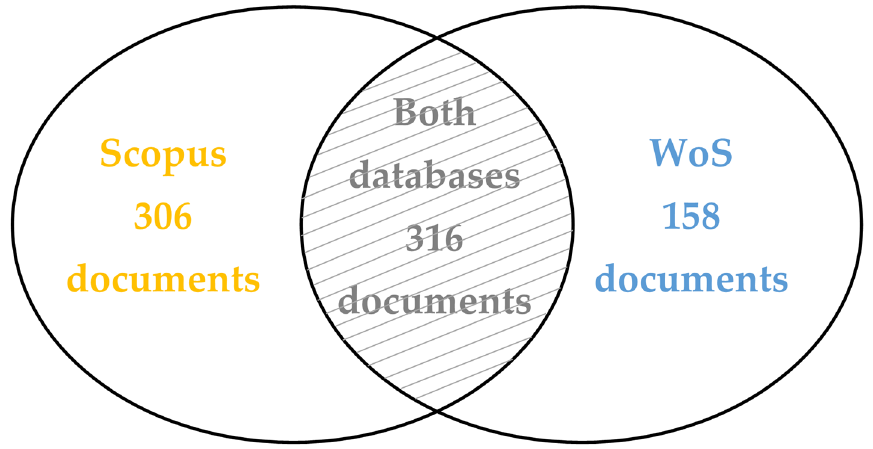
Figure 2. Total number of documents collected in the databases.